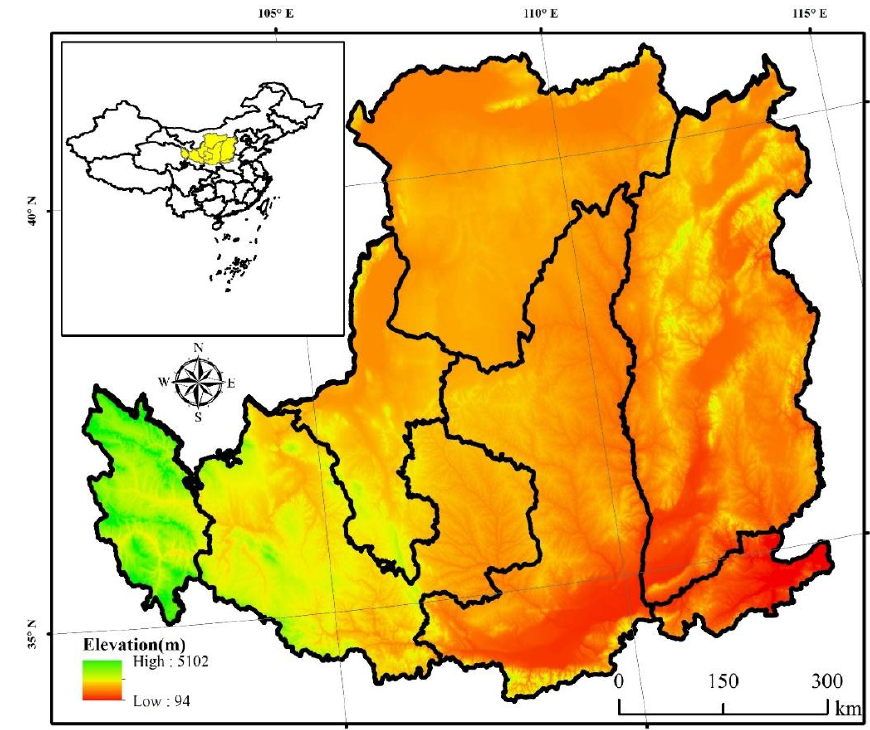
Figure 1. The study area and location of the Loess Plateau (LP) in China.